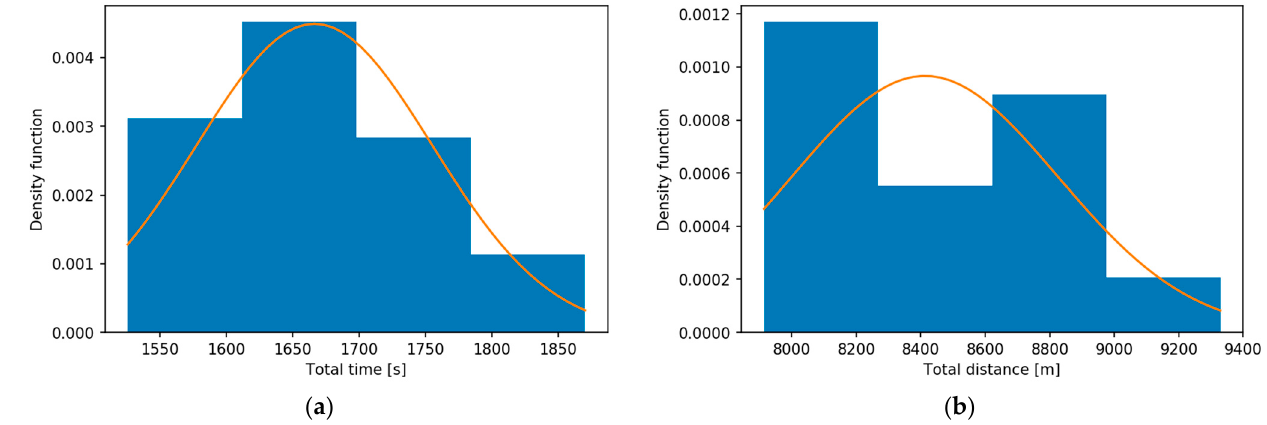
Figure 4. Histograms for 3D feasible MTSP routes according to time ( a ) and distance ( b ). Mean total time for all 3D feasible solutions was 1652 s, with population standard deviation of 88 s and spread between maximum and minimum time was 305 s. Mean dis-